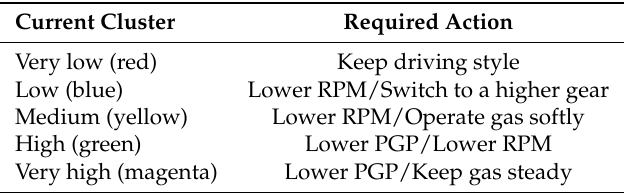
Table 8. Actions associated to the five-cluster